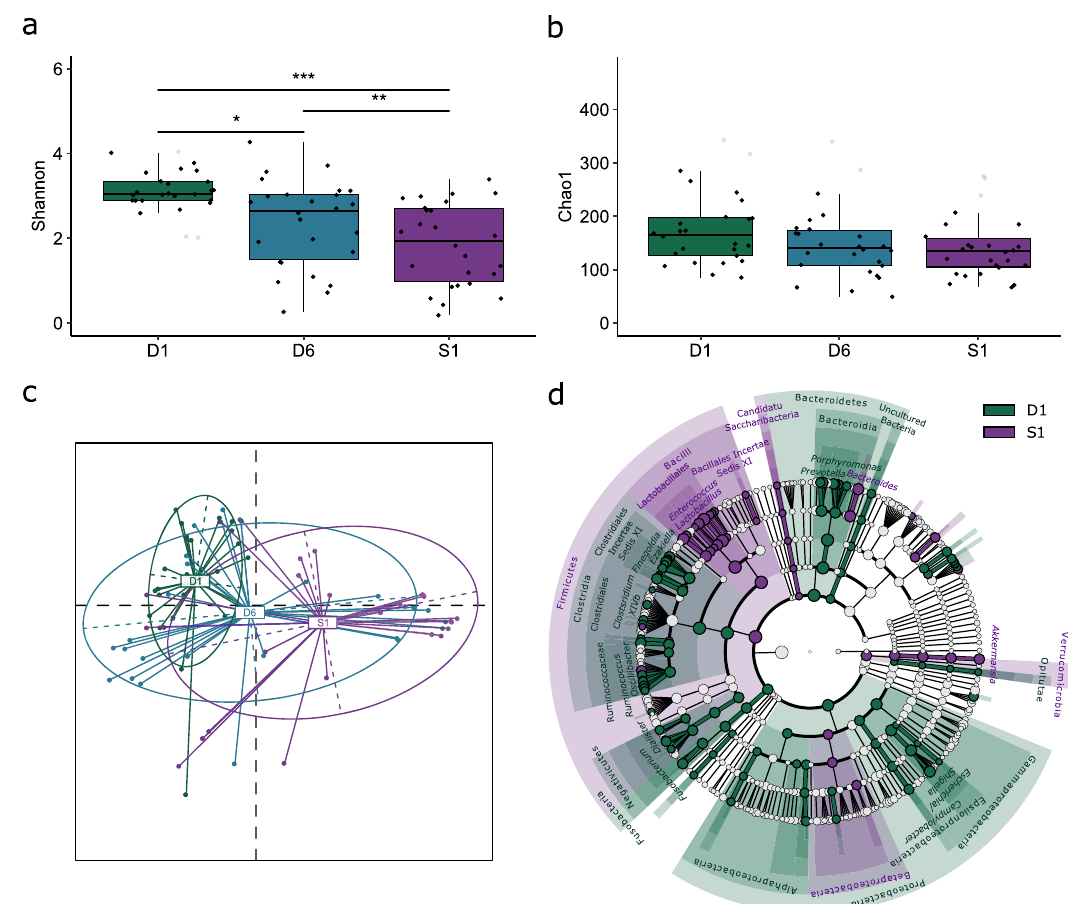
Fig. 5 Longitudinal analysis of microbial diversity and dysbiosis in patients developing AAD. Microbial diversity and composition in patients developing AAD in the study population ( n = 26) was assessed at D1 (green), D6 (blue), S1(purple). a Gradual decrease in Shannon diversity was observed between all timepoints (from D1 to D6: p = 0.018, from D1 to S1: p = 2.74*10 − 5 , from D6 to S1: p = 0.007). b Similar trends are observed for the Chao1 index (Friedman rank sum: p = 0.054). c Multi-dimensional scaling (MDS) shows distinct clusters for samples collected at each timepoint. d Comparison of the microbiota composition at D1 and S1 conducted using LEfSe (LDA > 2.0) shows large changes in the Firmicutes and Proteobacteria phyla for AAD patients. Proteobacteria are signi fi cantly reduced at the occurrence of AAD, and a shift is observed from the Clostridia to Bacilli class at the instance of diarrhea. The cladogram shows distinct taxa of interest. For more details, see Supplementary Fig. 5. Alpha diversity indices were compared using the paired two-sided non-parametric Wilcoxon signed rank test followed by Bonferroni correction of p -values. Box plots indicate median (middle line), 25th, 75th percentile (box), and 5th and 95th percentile (whiskers) as well as outliers (gray single dots). AAD: patients with non- C. dif fi cile antibiotic-associated diarrhea. D1: rectal swab sample collected upon study enrollment. D6: rectal swab collected ~6 days after initiation and at the end of antibiotic treatment. S1: stool sample collected at the fi rst occurrence of diarrhea (variable time-point). LEfSe: linear discriminant analysis effect size. LDA: Linear discriminant